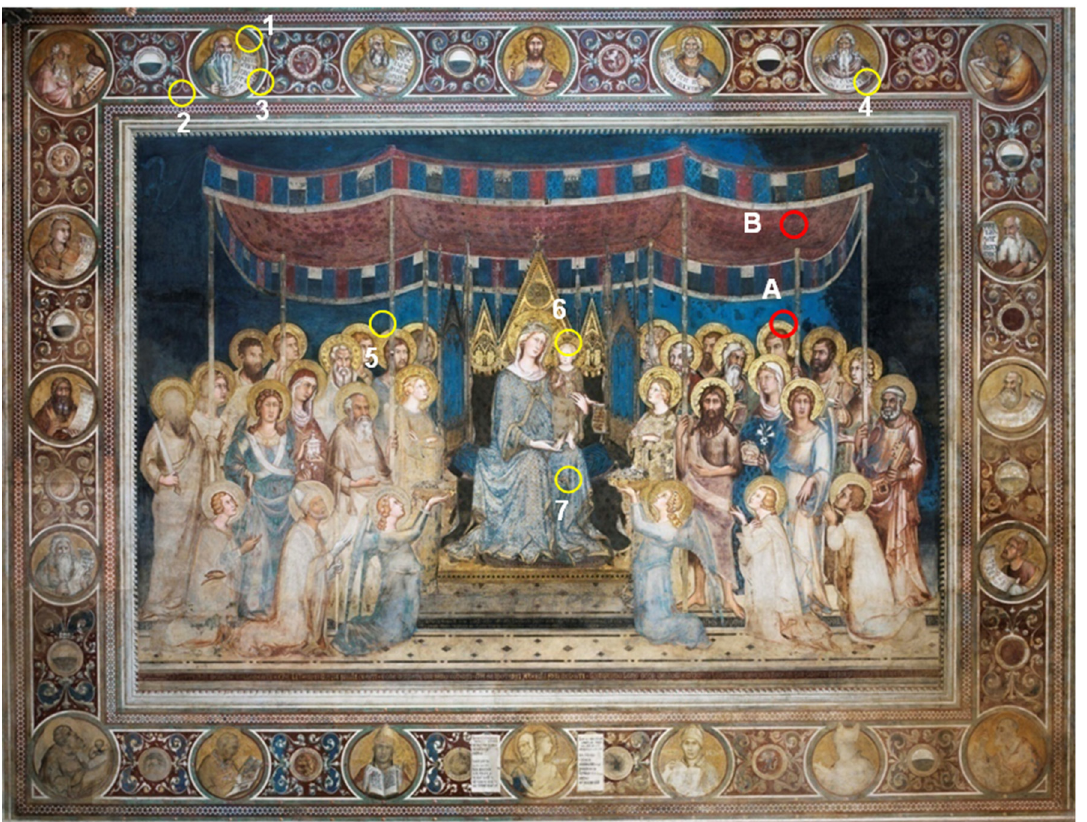
Figure 1. Wall painting “La Maestà” by Simone Martini. The sampling points are marked with yellow and red circles. The results of the analysis presented here are for sample A (halo of St. Taddeus, middle right of the painting) and sample B (decoration of the canopy, top right of the painting).